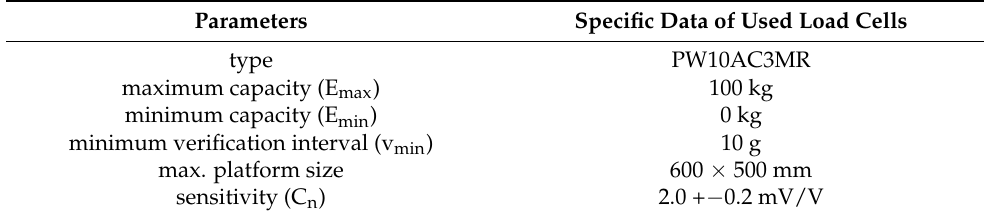
Table 2. Overview of technical data of used load cells (based on Hottinger Baldwin Messtechnik GmbH [37]).